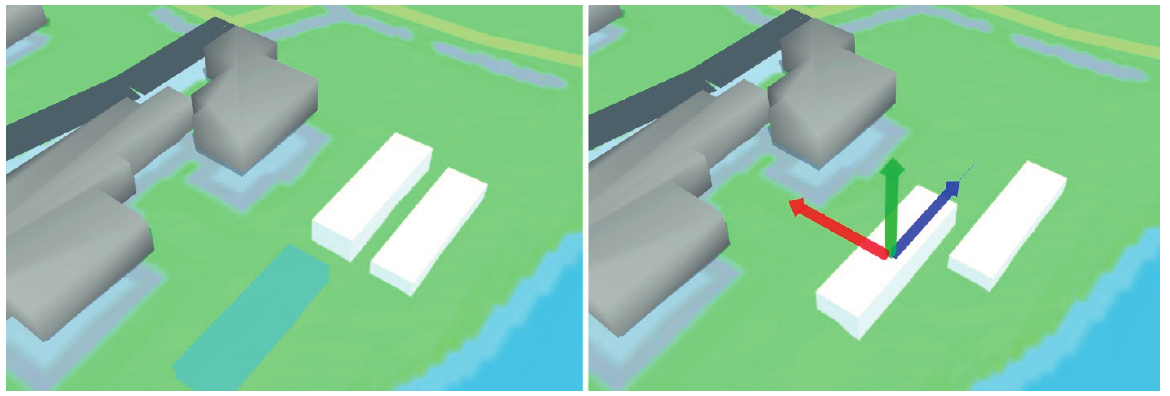
Figure 9. User adding a block element, and moving a block